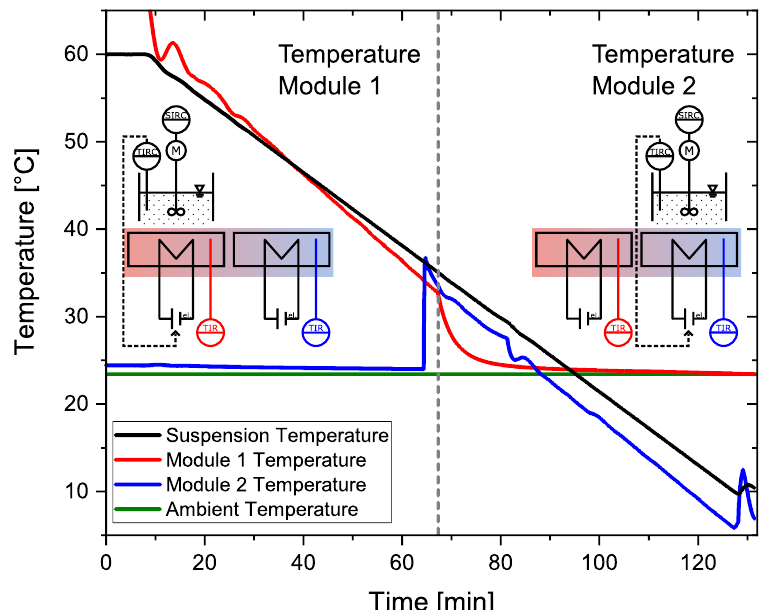
Figure 5. Demonstration of the continuation of a temperature module across two temperature modules. The target profile is linear from 60°C to 10°C in 120min with 100g sucrose solution (saturated at